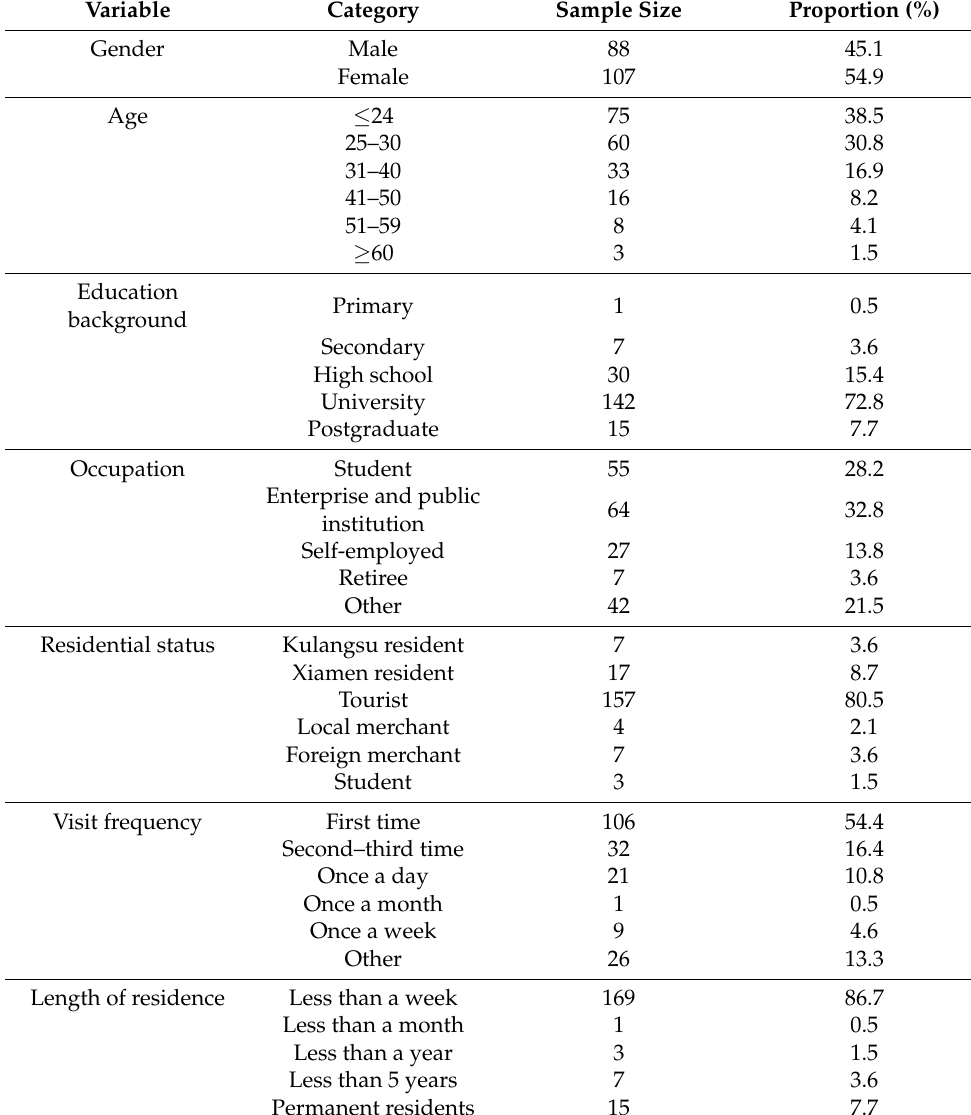
Table 2. Sample information of the questionnaire database, N =